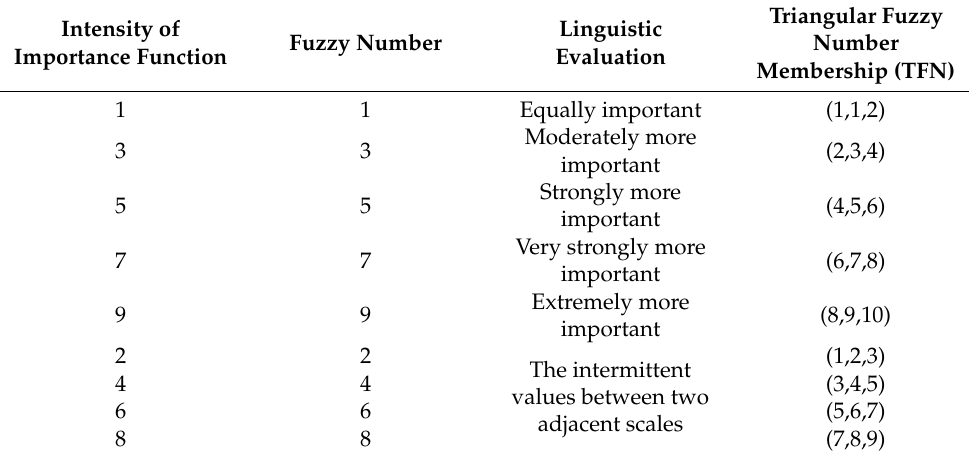
Table 6. Fuzzy scale based on fundamental comparative scale [123].